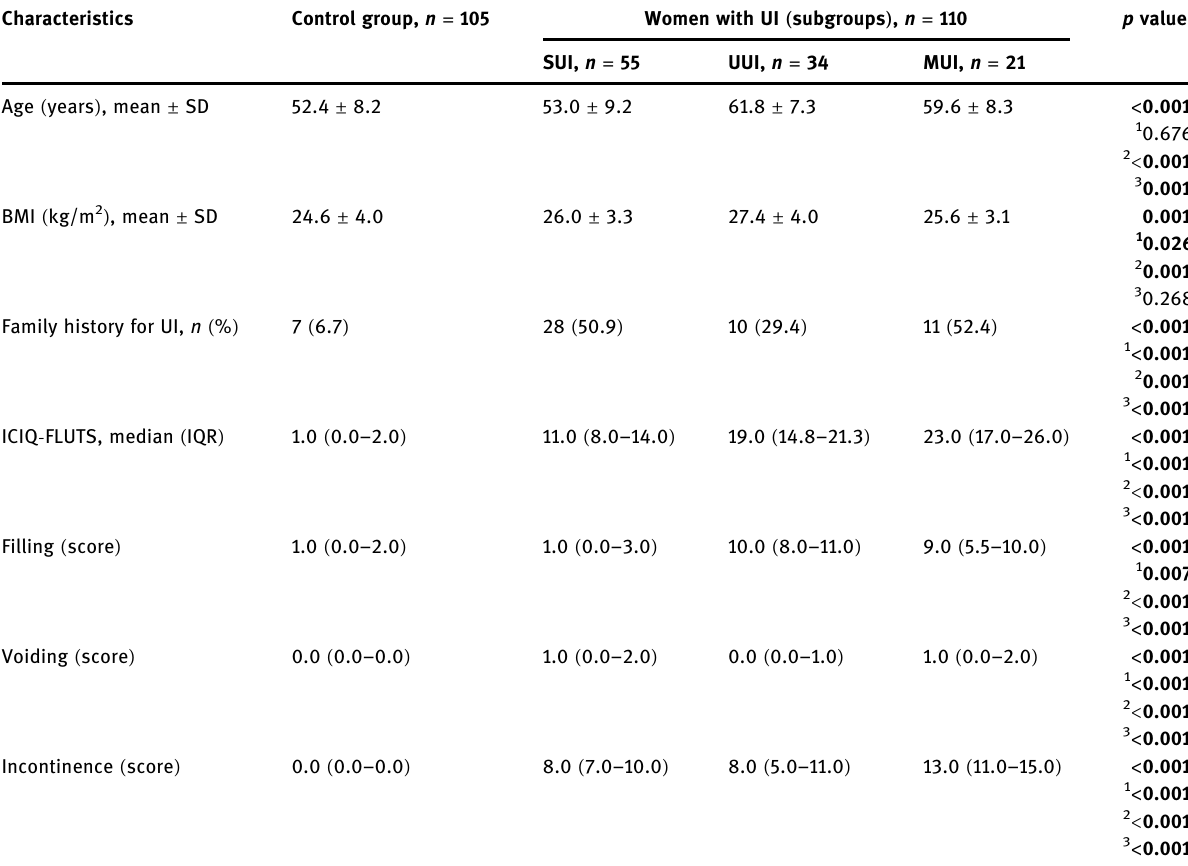
Table 1: The comparison of sociodemographic and clinical data among women with UI and control group